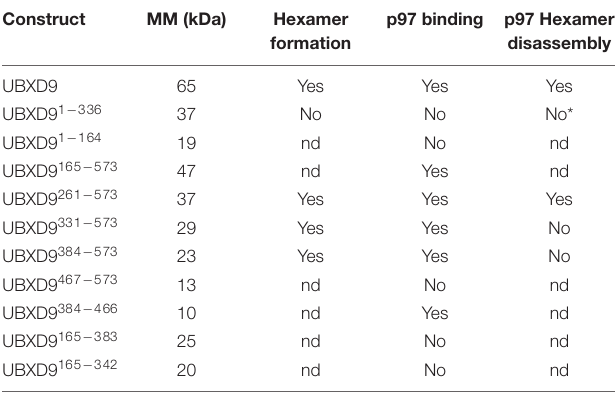
TABLE 1 | Summary of biochemical properties of full length UBXD9 and UBXD9 truncation